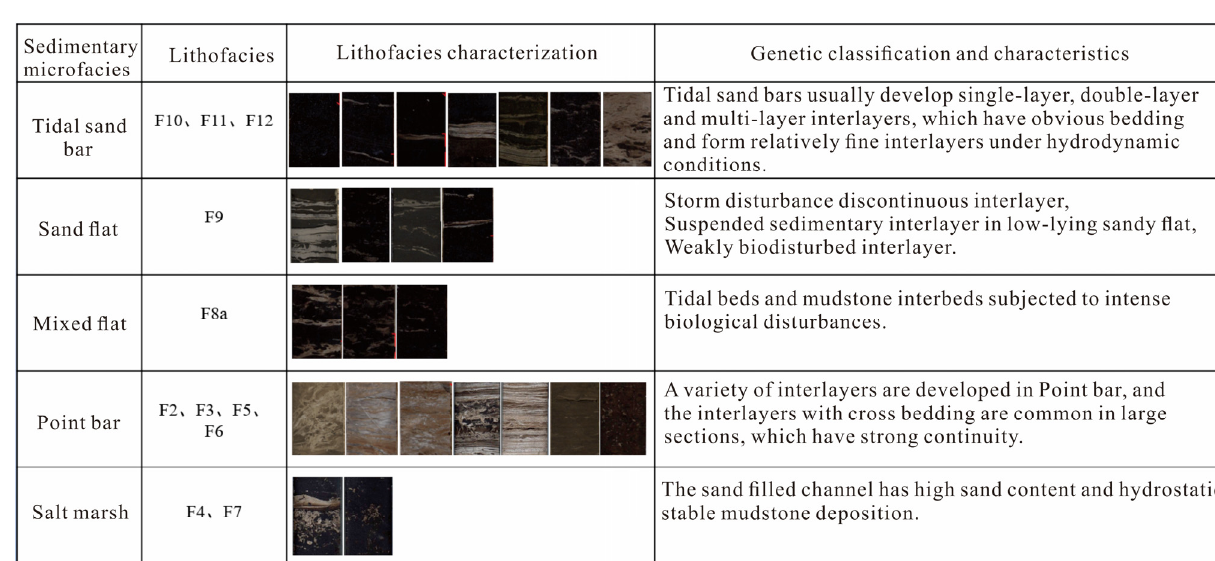
Figure 4. Categories of lithofacies.